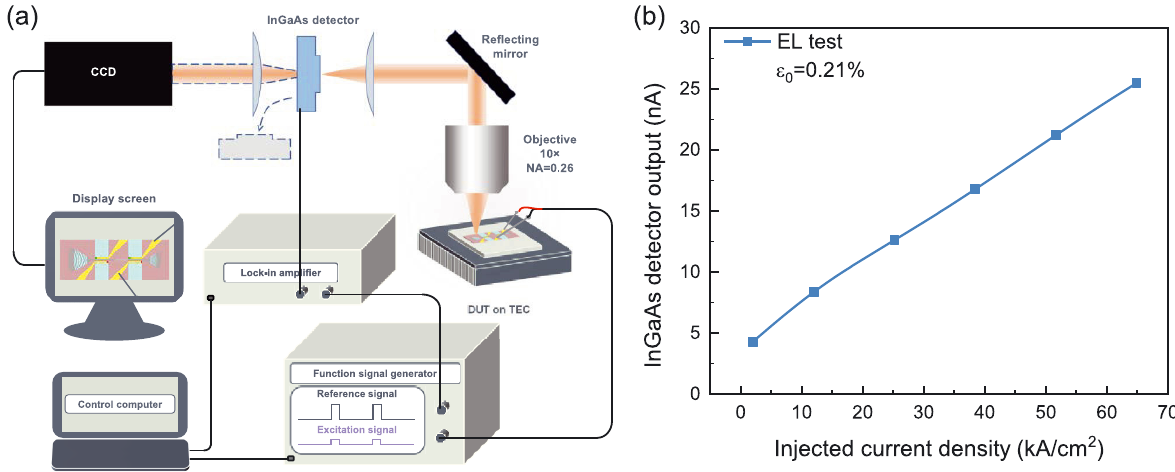
Figure 10: (a) Schematic of the electroluminescence test set-up used in this work. (b) EL test result of the unsuspended